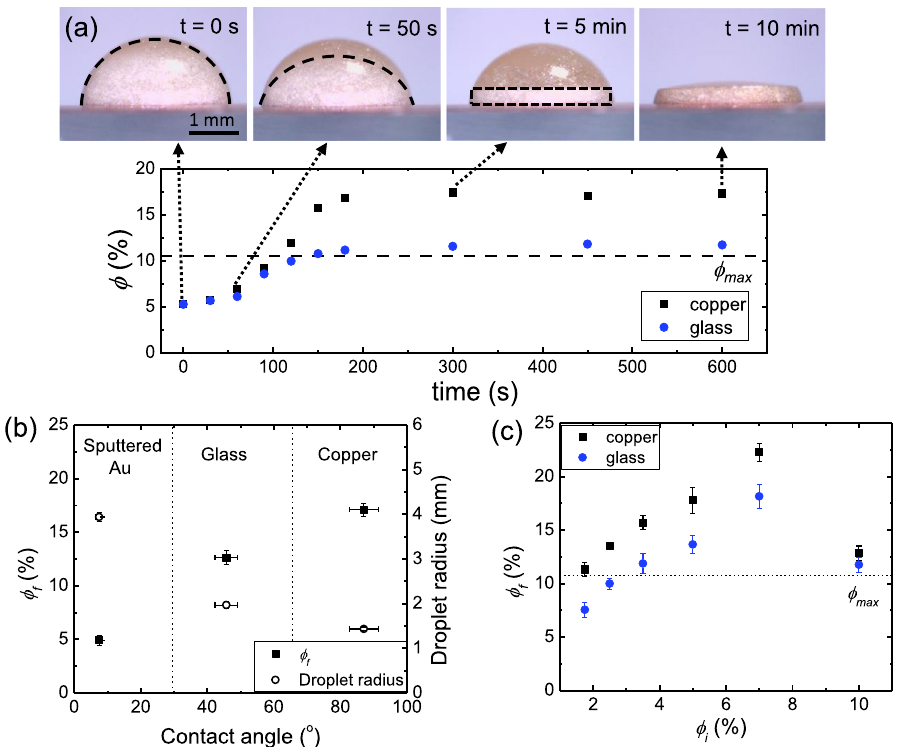
Fig. 2 | Increase of platelet concentration in the deposited and vertically aligned xirallic droplets. a Top panel shows the optical images of a vertically alignedxirallicdropletduringsedimentationanddryingonacoppersubstrate.The dotted region represents the volume which the xirallic platelets become con- centrated during sedimentation. Bottom panel shows the platelet volume fraction ϕ asafunctionoftimefordropletsdepositedontotwodifferentsubstrates,copper (black) and glass (blue), for an initial ink concentration of 5vol%. ϕ max represents